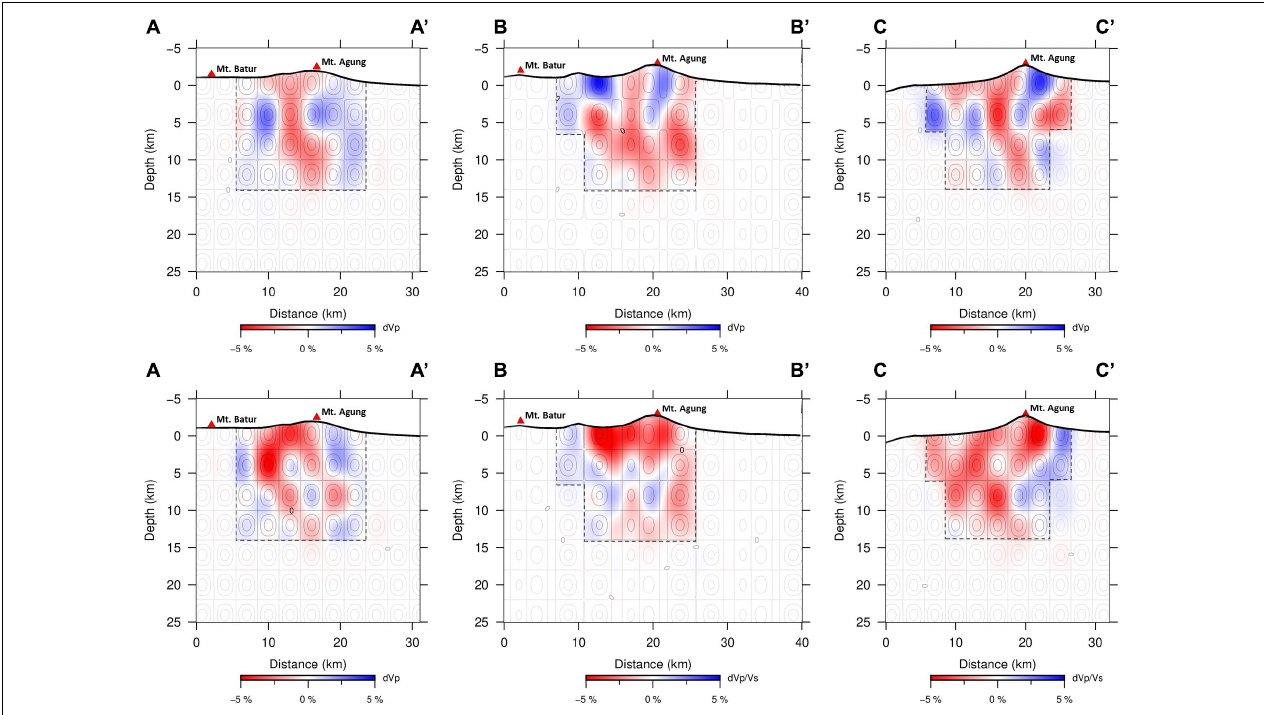
FIGURE 2 | Vertical cross-sections of recovered Vp checkerboard resolution tests (CRT) model (top row), and recovered Vp/Vs CRT model (bottom row). The thin black line is the contour of the initial CRT model for Vp and Vp/Vs with interval of 4. Dashed black lines define the area which has a good resolution. Blue and red colors respectively represent high and low seismic velocity anomaly values, according to the scale at the bottom of each row. The vertical cross-section is taken at (A-A’) (first column), (B-B’) (second column), (C-C’) (third column), the spatial location of each cross-section, as seen in Figure 1C